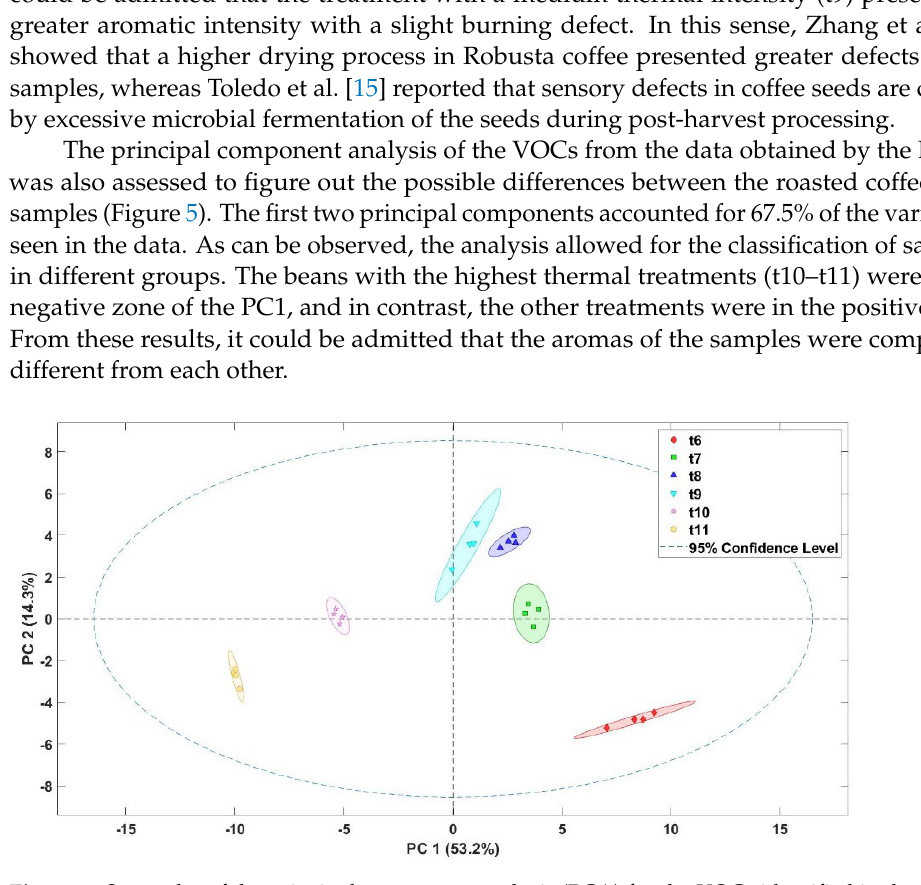
Figure 5. Score plot of the principal component analysis (PCA) for the VOCs identified in the roasted coffee beans submitted to different thermal treatments (t6–t11).